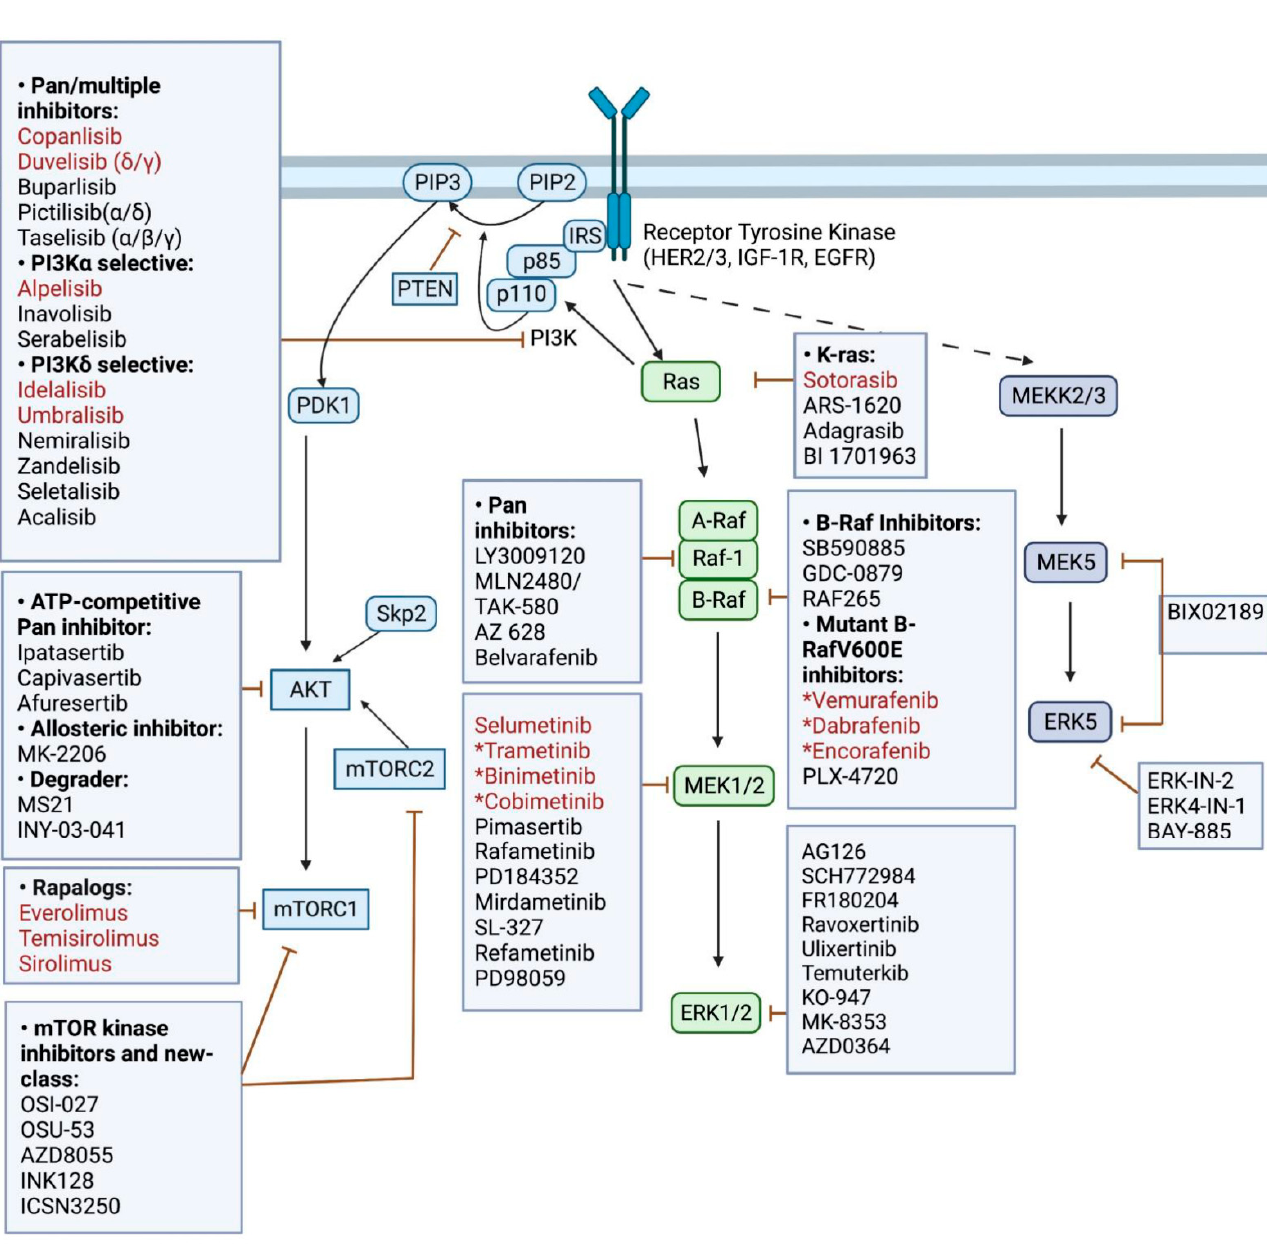
Figure 2. The overview of PI3K/AKT/mTOR, RAS-RAF-MEK-ERK, and MEK5/ERK5 pathway, with their respective small molecule inhibitors . The immune-modulatory effect of both PI3K and MAPK inhibition provides a promising option to overcome therapeutic resistance with ICIs. Dual- targeted inhibition of MAPK and PI3K pathway effectors in combination or with sequential treatment with ICIs may present a potential strategy to overcome resistance in patients with tumors harboring both pathway-associated mutations. FDA-approved therapeutic agents are denoted in red. Inhibitors with an asterisk (*) are approved in melanoma. Created with BioRender.com.